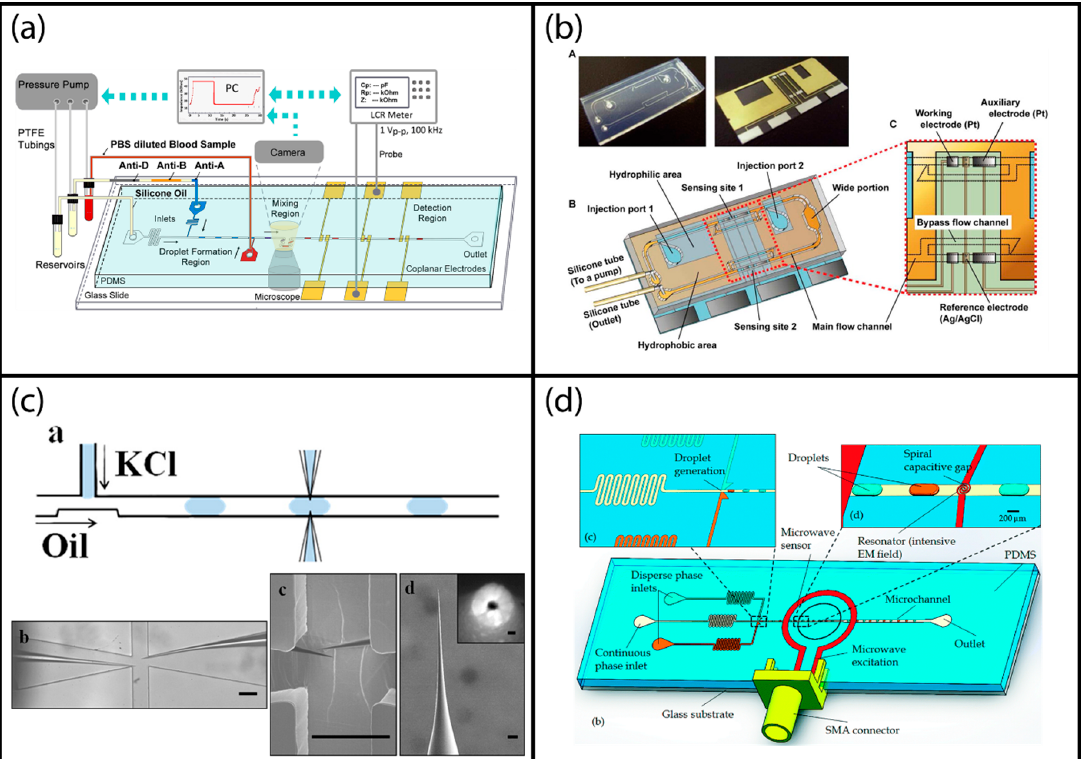
Figure 6. Examples of label-free electrical droplet detection: ( a ) Impedimetric detection of hemagglutination inside segmented droplets; reproduced from [73]. ( b ) Electrochemical detection of ATP concentration in fish extracts to determine fish freshness; reprinted with permission from [84]. American Chemical Society (2013). ( c ) Resistive pulse sensing integrated to a segmented droplet system using quartz capillaries; adapted with permission from [86]. Copyright 2014 American Chemical Society. ( d ) Microwave sensing of segmented droplets at GHz range; adapted from [88] with permission of The Royal Society of Chemistry.